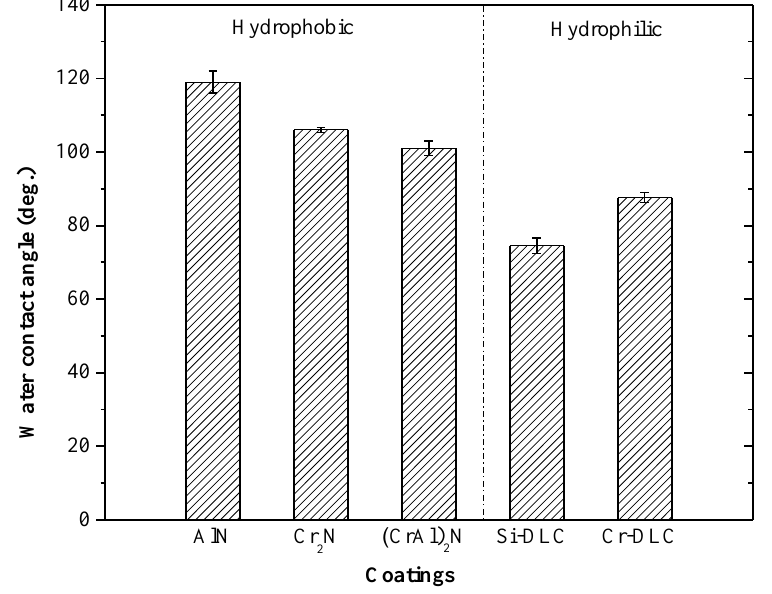
Figure 4. Water contact angle (WCA) of as-deposited